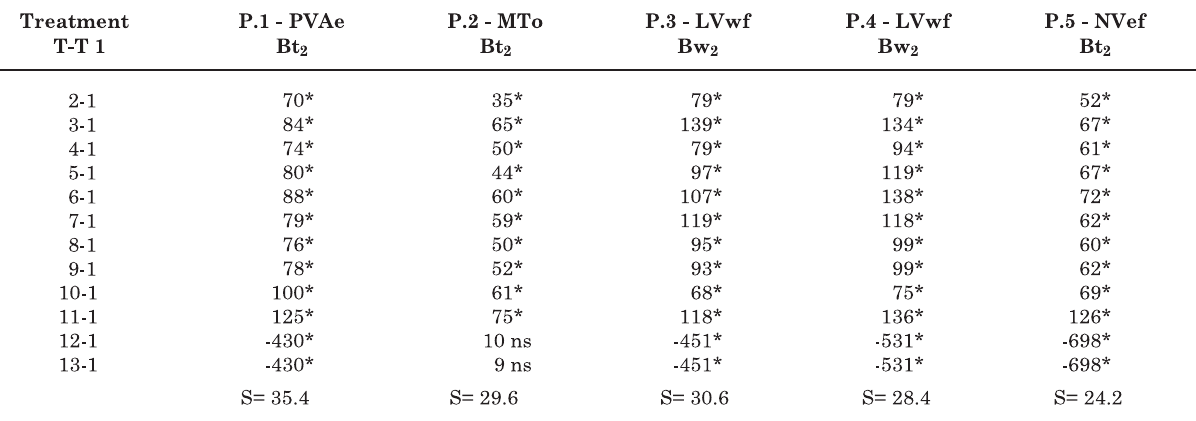
Table 4. Difference in the mean clay contents (g kg -1 ) between the dispersion treatments (T) and the standard treatment (T1) in samples collected from horizon B of five